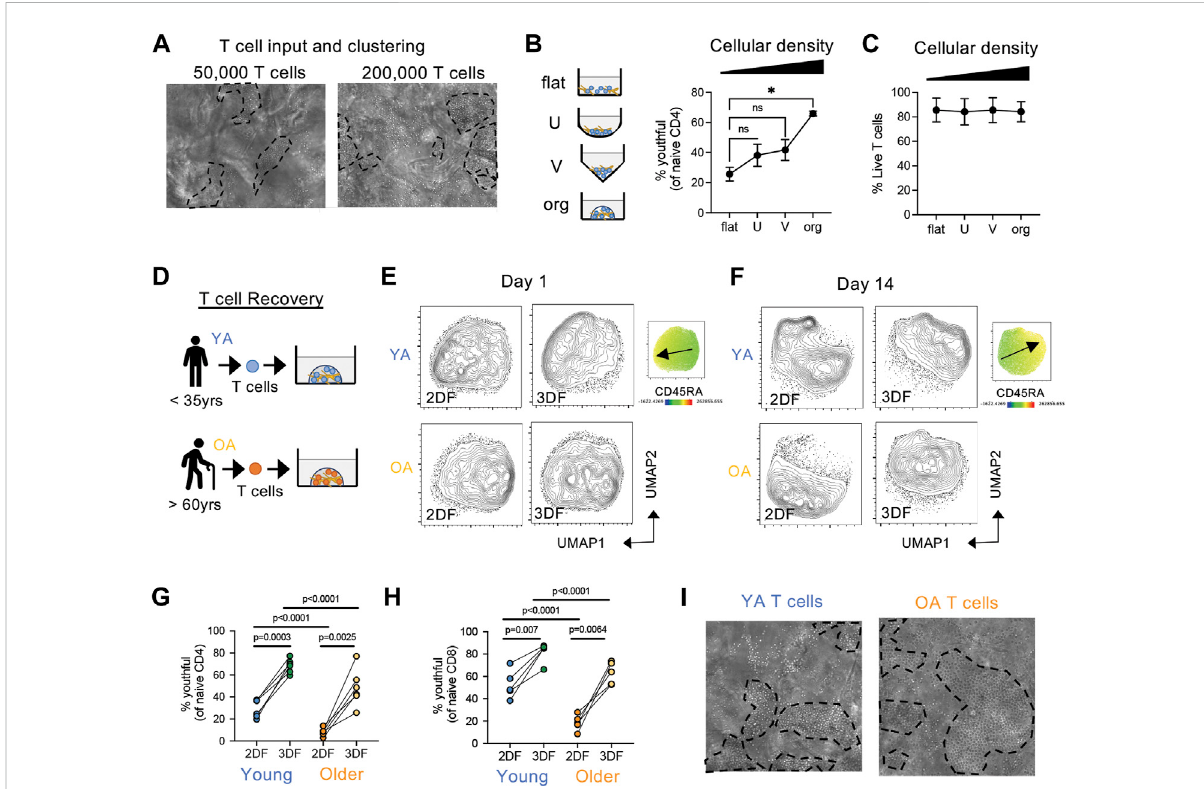
FIGURE 7 StructureandcelldensityeffectnaïveTcellphenotypeandtheconversionfromCD45RA high toCD45RA low . (A) ClusteringofTcellsinorganoids at different cell densities after 7 days. Representative of three independent experiments. (B,C) Effect of cell density/contact capability on (B) CD45RA high CD27 high naïve CD4 T cells and (C) T cell viability in young donor T cells ( n = 3). T cells were cultured with FRCs (from young adult) in fl at, U-bottom, V-bottom or organoids for 14 days. (D) T cells were isolate from young (YA; 35 years or less) and older (OA; 60 years or older) adult peripheral blood and cultured in organoids with FRCs (from young adult). (E,F) Analysis of naïve CD4 T cell similarly at (E) day 1 and (F) day 14 post- culturing. CD45RA expression map is on the right with arrow indicating low to high expression. (G,H) Frequencies of CD45RA high CD27 high (G) CD4and (H) CD8naïveTcellsfromyoung ( n =6CD4, n =5CD8)andolder( n =6CD4, n =5CD8)donors. (I) ClusteringofTcellsfromyoung orold donors in organoids. Representative of more than three independent experiments. * p < 0.05 p -values were determined by (B,C) Friedman test with Dunn ’ s multiple comparison test, and (G,H) Mixed-effects analysis with Holm-Sidak multiple